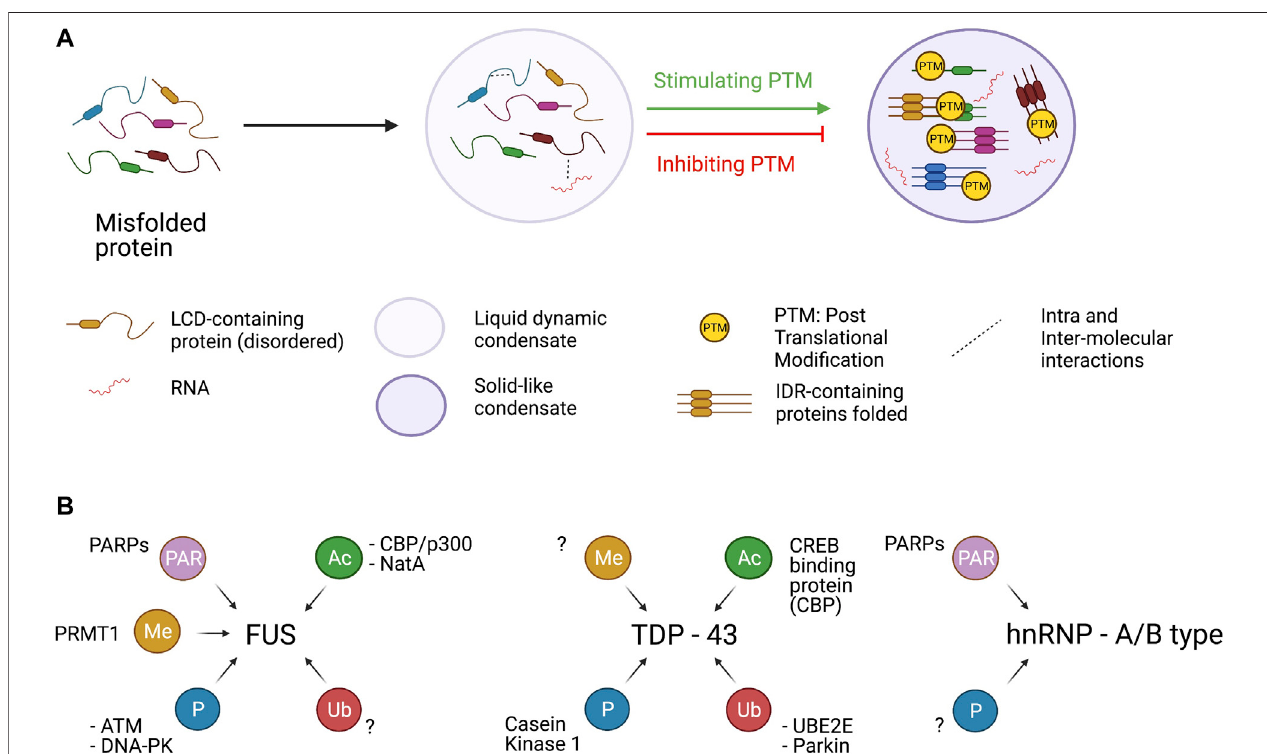
FIGURE 2 | Assembly of condensates and PTMs. Panel A . LCD-containing proteins (including TDP-43, FUS and hnRNPA1) under certain conditions assume a misfolded state in which several intra and inter-molecular interaction can be established. Different PTMs tend to stimulate or dampen the formation of insoluble condensateinwhichLCD-containingproteinsaresequesteredinatoxic β -sheetstructure.However,PTMhasprotein-andresidue-speci fi cimpactonproteinaggregate formation. Panel B . hnRNPA1, FUS and TDP-43 can be target of several PTMs catalyzed by speci fi c enzymes. hnRNP-A1 and FUS can be PARylated by PARPs and PARP1, respectively. FUS protein can be methylated by PRMT1 acetylated by CBP/p300 and NatA. Moreover, the Prion like domain of FUS is phosphorylated at multiple sitesbythetwokinasesATMandDNA-PK.TDP-43isactively acetylatedbyCBPandphosphorylatedbyCasein Kinase.Finally, UBE2Eand Parkincatalyzethe ubiquitination of